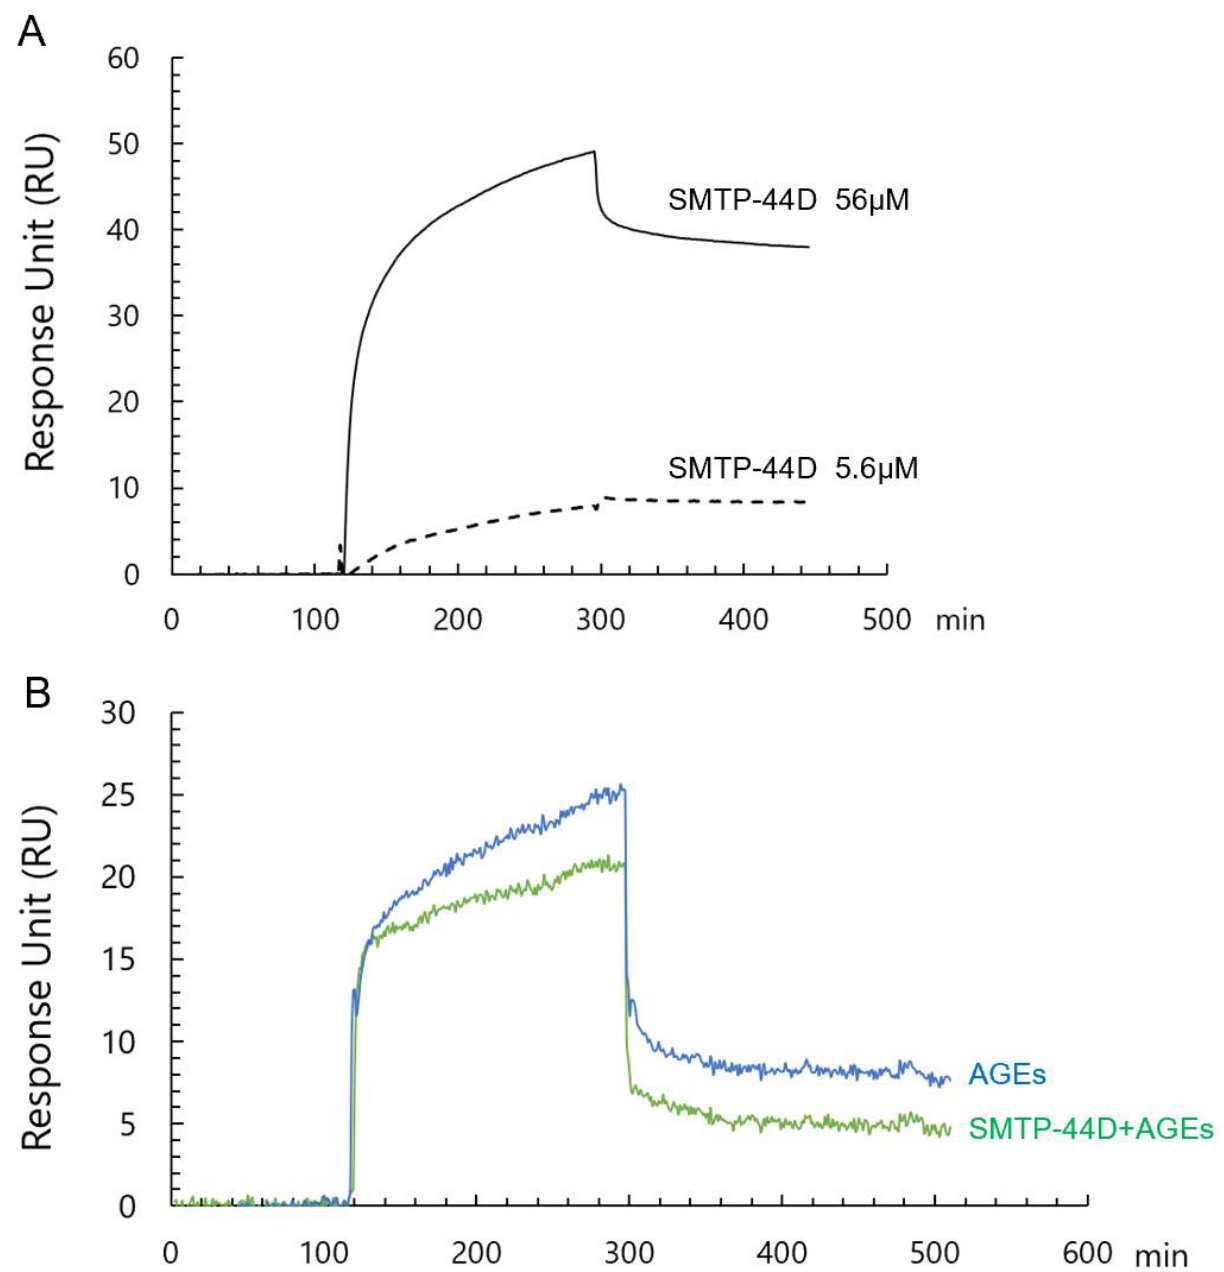
Figure 2. Interaction of SMTP-44D at 56 µ mol/L and 5.6 µ mol/L to immobilized RAGE was analyzed by bio-layer interferometry using BIAcore system ( A ). Effects of 56 µ mol/L SMTP-44D on the interaction of 250 µ g/mL AGEs with immobilized RAGE were evaluated ( B ). The binding protein is expressed as RU.